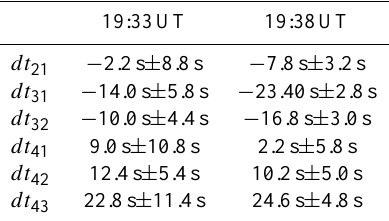
Table 1. Inter-spacecraft delays determined for the B N signature observed by Cluster at 19:33 and